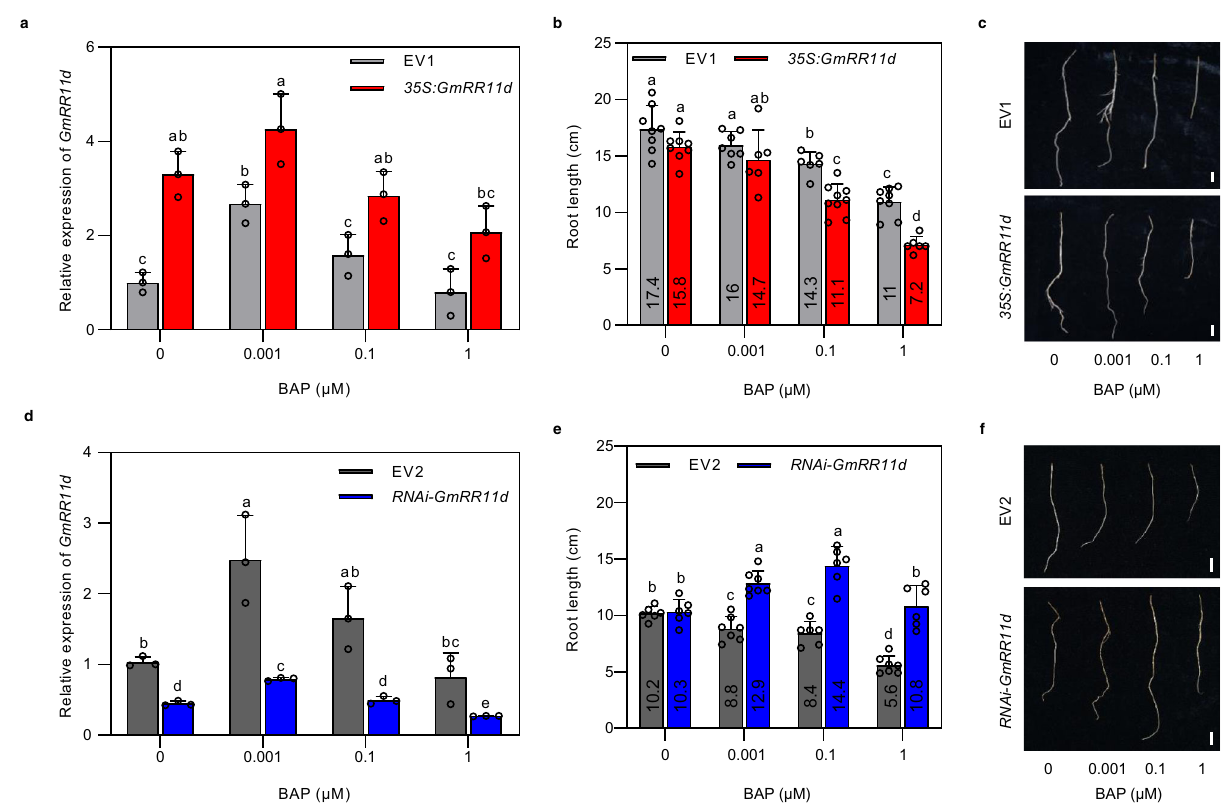
Fig. 2 | GmRR11d is CK responsive and positively regulates the sensitivity of soybean roots to CKs. a Relative expression of GmRR11d in transgenic roots expressing 35S : GmRR11d treated with BAP of different concentrations (0, 0.001, 0.1, 1 μ M). The expression levels were normalized against the geometric mean of soybean GmELF1b . Data are presented as means±SD from three biological repli- cates. Different letters indicate signi fi cant differences at p <0.05 (Two-way ANOVA). b Length of hairy roots expressing EV1 and 35S : GmRR11d treated with different concentrations (0, 0.001, 0.1, 1 μ M) of BAP for 6 days ( n ≥ 6). Data are presented as means±SE. Different letters indicate signi fi cant differences at p <0.05 (Two-way ANOVA). c Representative images of individual root over- expressing GmRR11d and the EV1. Three independent experiments were repeated